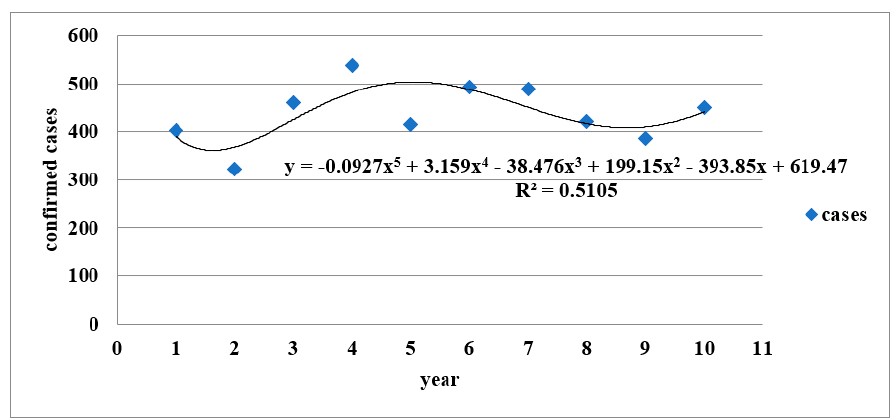
Figure 4. Polynomial regression prediction of domestic and imported cases with scrub typhus in Taiwan between 2010 and 2019. Numbers 1–10 on the x –axis represent 2010–2019. (2) The seasonal index of local cases of scrub typhus is shown in Table 6. The seasonal index for summer was 1.193 in June, 1.187 in July and 0.62 in August. The seasonal index for autumn was 1.012 in September, 1.263 in October and 0.725 in November. Table 6. Seasonal index of summer and fall from a survey of domestic and imported cases of scrub typhus between 2010 and 2019 in Taiwan.